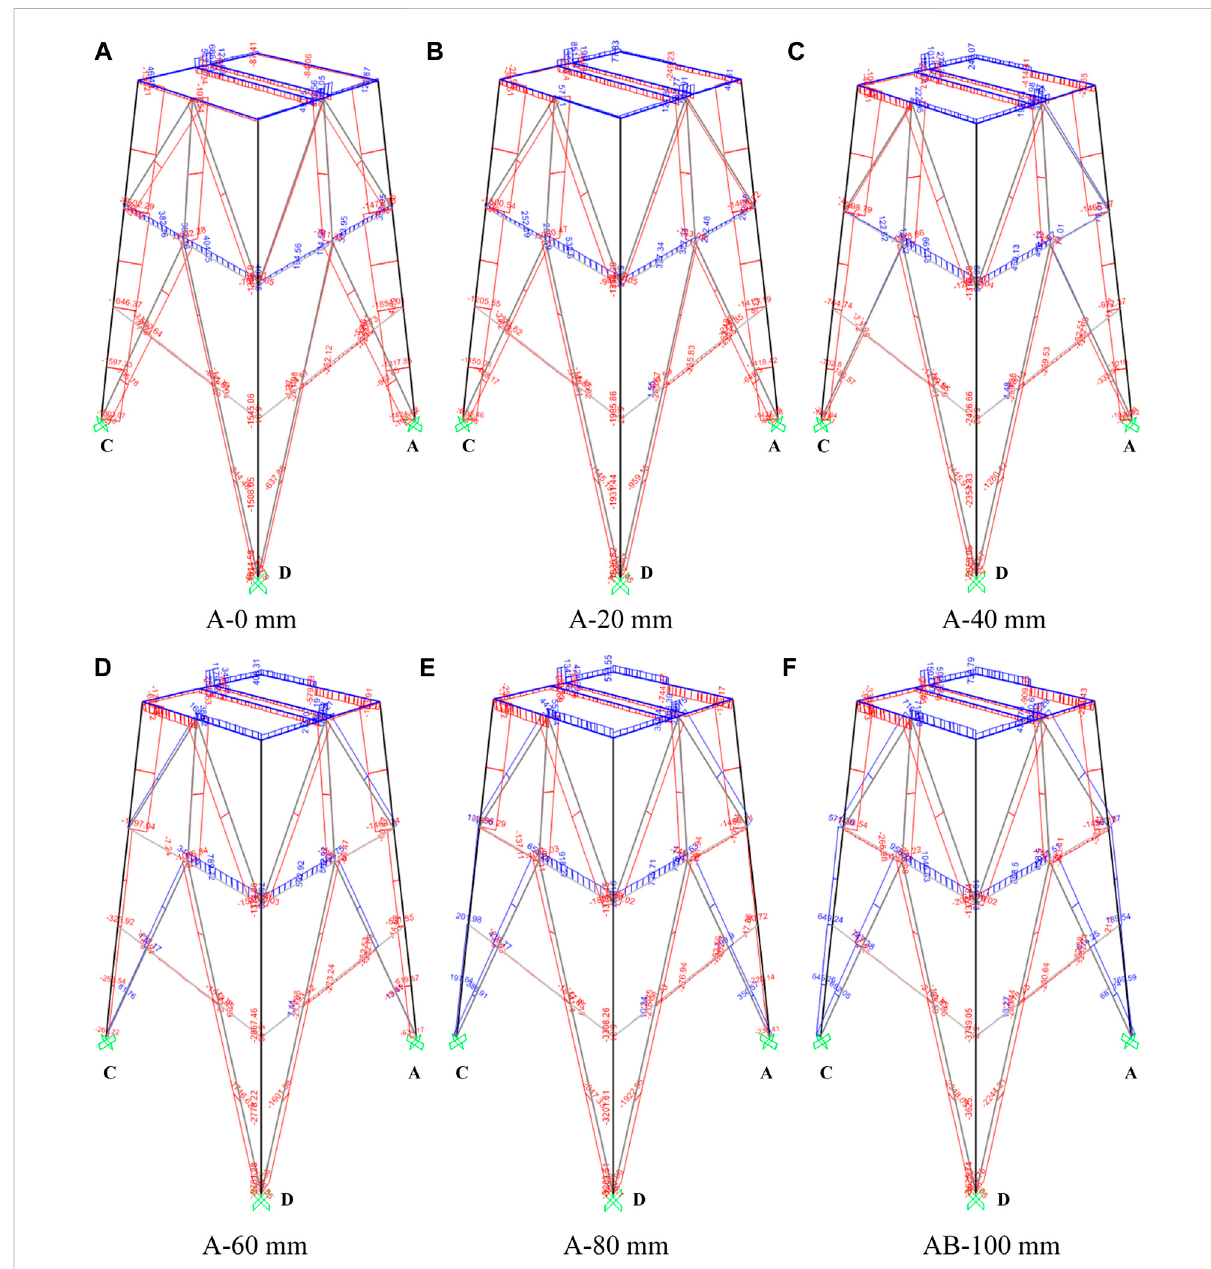
FIGURE 6 AxialforceofthemembersversusthesettlementofasinglefoundationA. (A) A-0 mm (B) A-20 mm (C) A-40 mm (D) A-60 mm (E) A-80 mm (F) AB-100